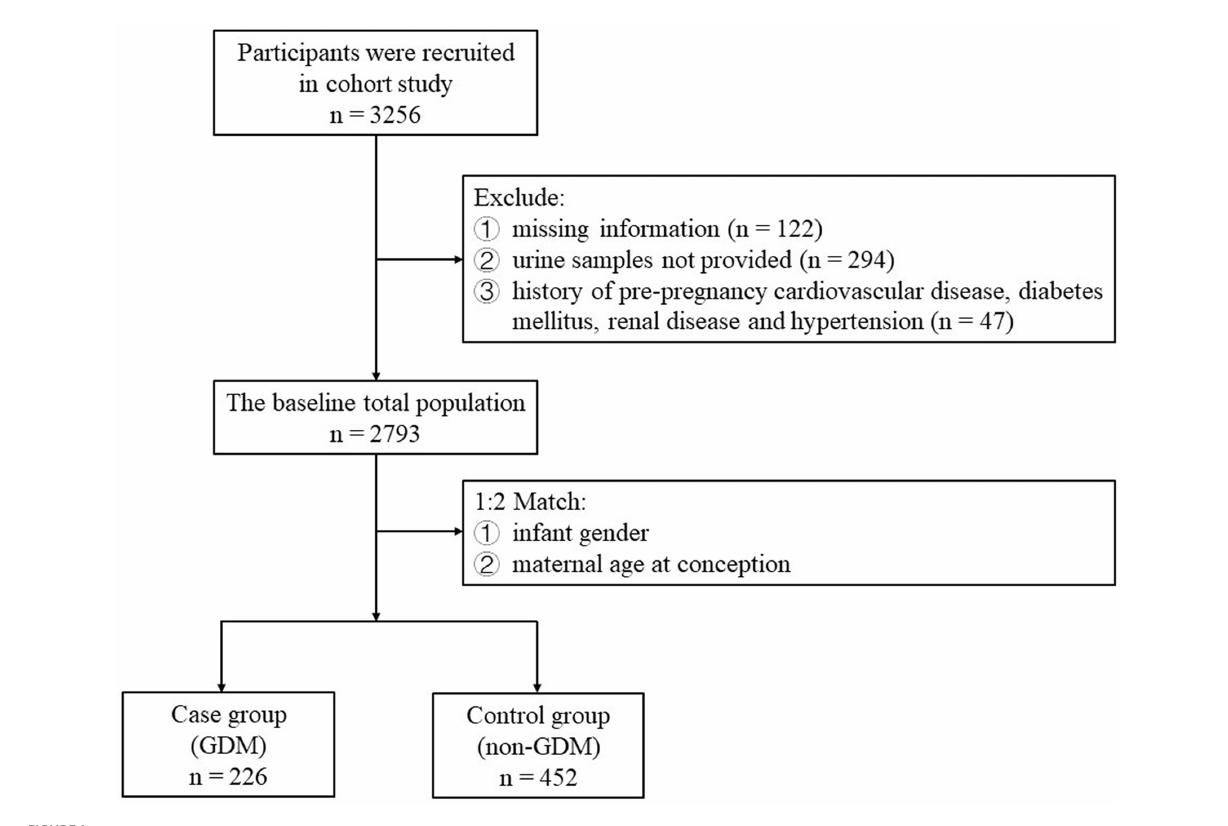
FIGURE 1 Flowchart of participant recruitment and case–control